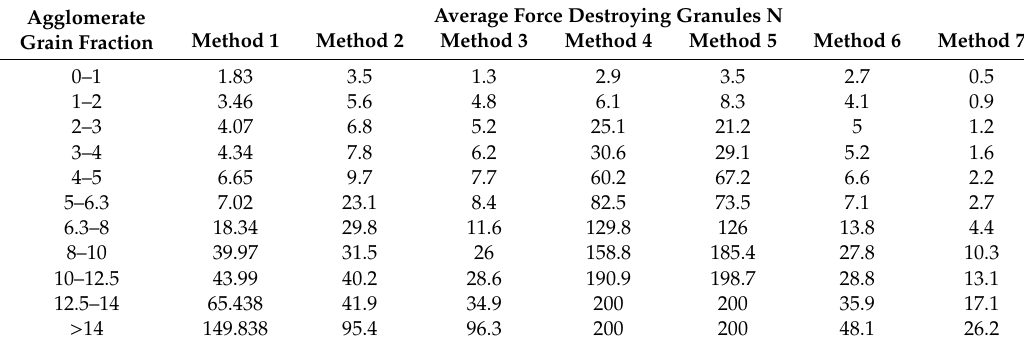
Table 3. Average force destroying granules.